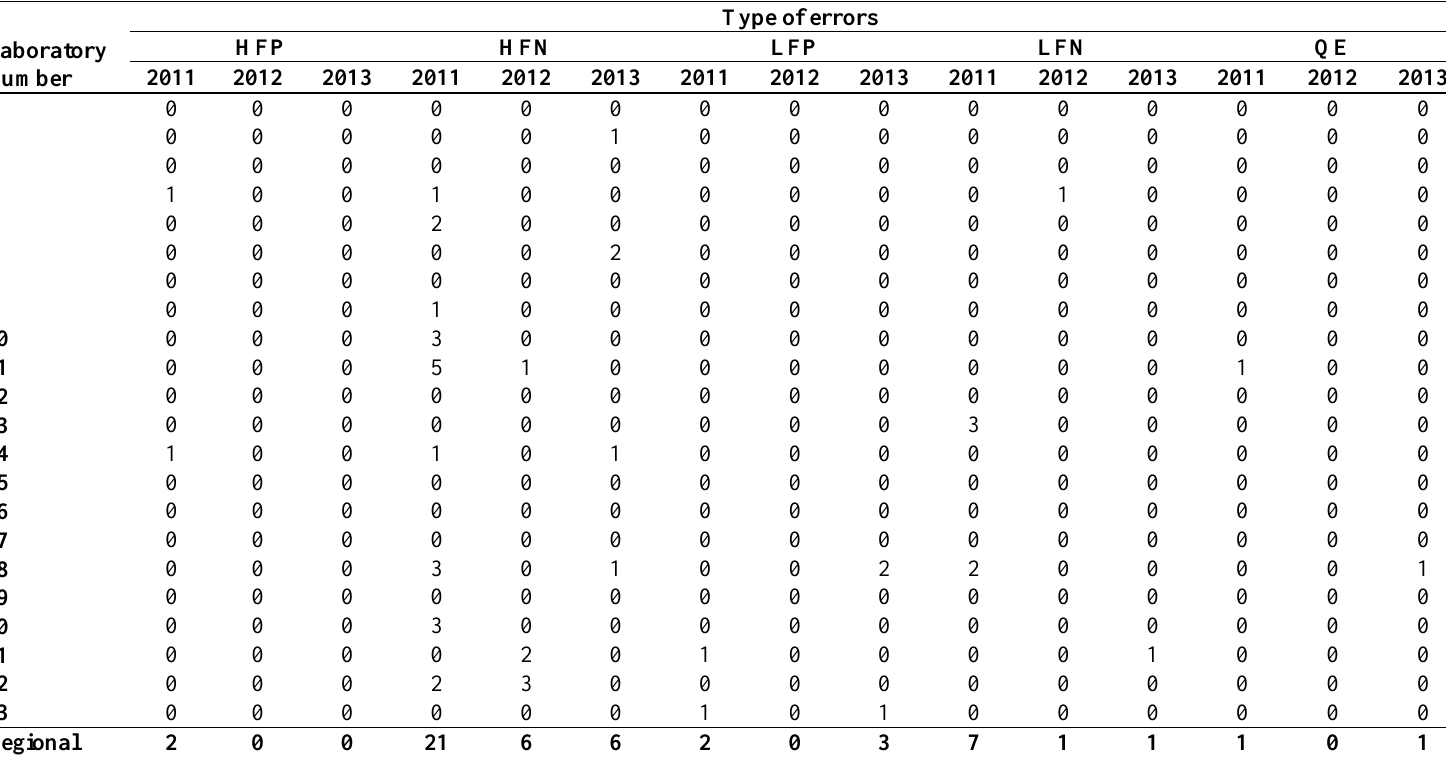
Table 3: Annual EQA rechecking results, by laboratory